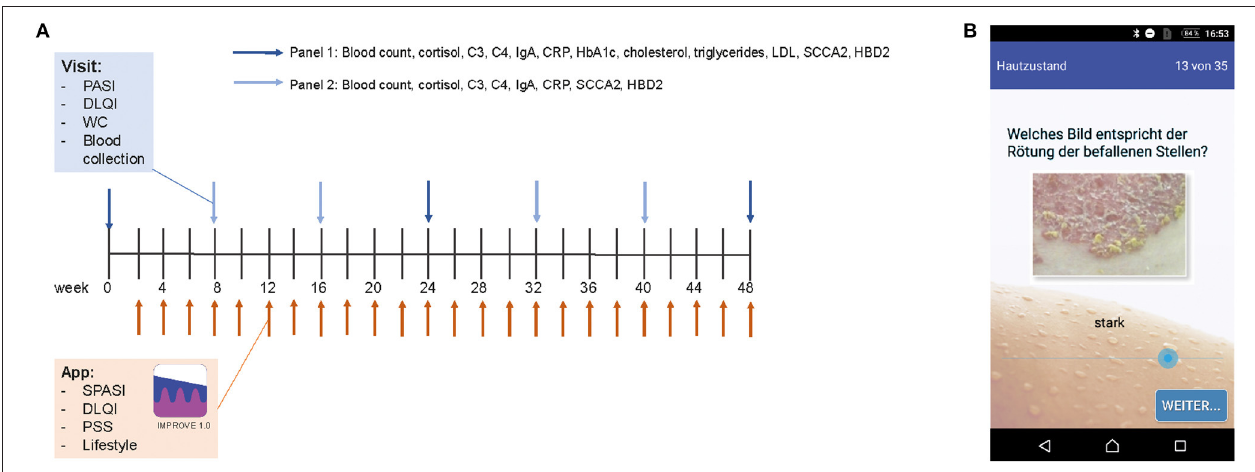
FIGURE 1 | Study design and app. PASI, DLQI, and waist circumference (WC) of psoriasis patients were assessed every 8 weeks. Besides, blood was taken and examined for blood counts and serum parameters (Panel 1 at visits 2, 3, 5, and 6 and Panel 2 at visits 1, 4, and 7) (A) . Biweekly, patients filled out an app questionnaire including SPASI, DLQI, PSS, and questions on lifestyle factors. Assessment of disease severity was supported visually by example pictures of psoriasis for redness, thickness, and scaling (here exemplarily shown for redness) (B) .